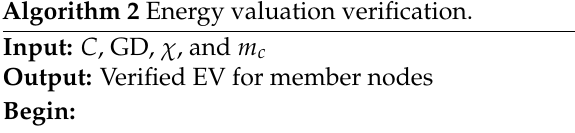
Figure 4. Procedural flowchart for ad hoc mobile cloud formation. Algorithm 2 Energy valuation